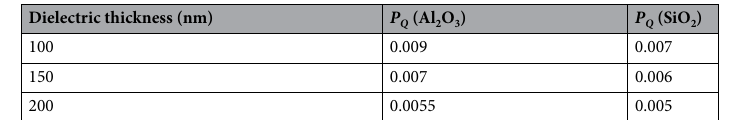
Table 1. Representative measured empirical surface charge coefficients for three different thicknesses of Al 2 O 3 and